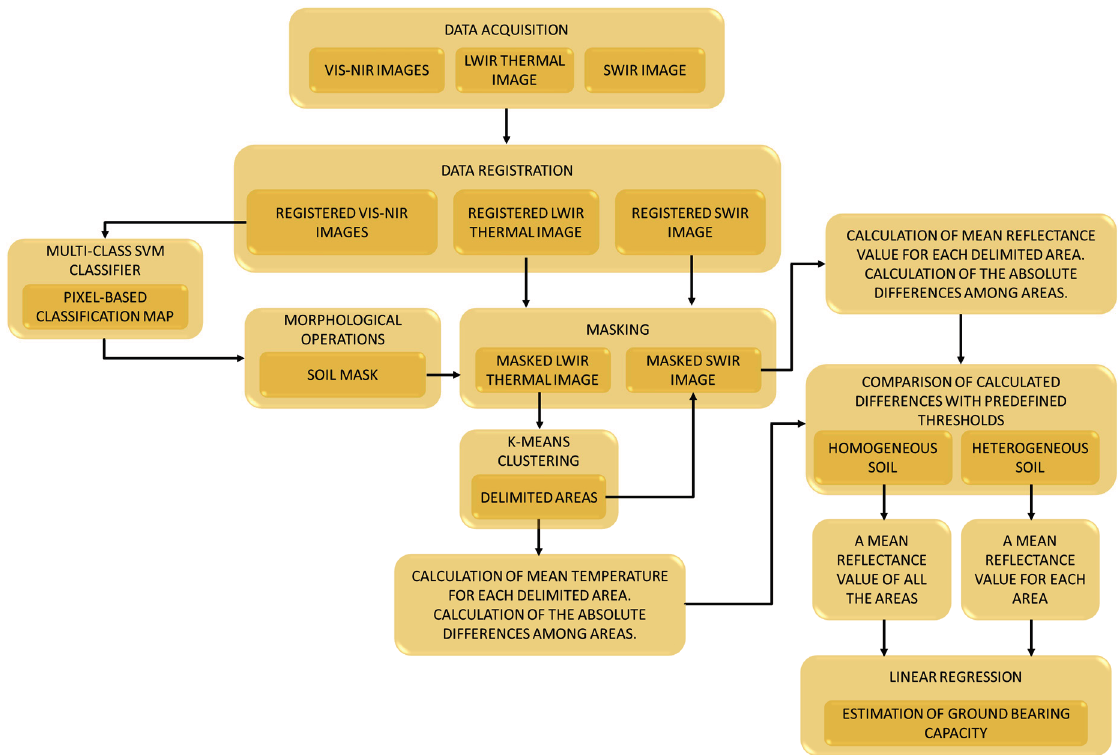
Figure 3. Proposed methodology for estimating the ground bearing